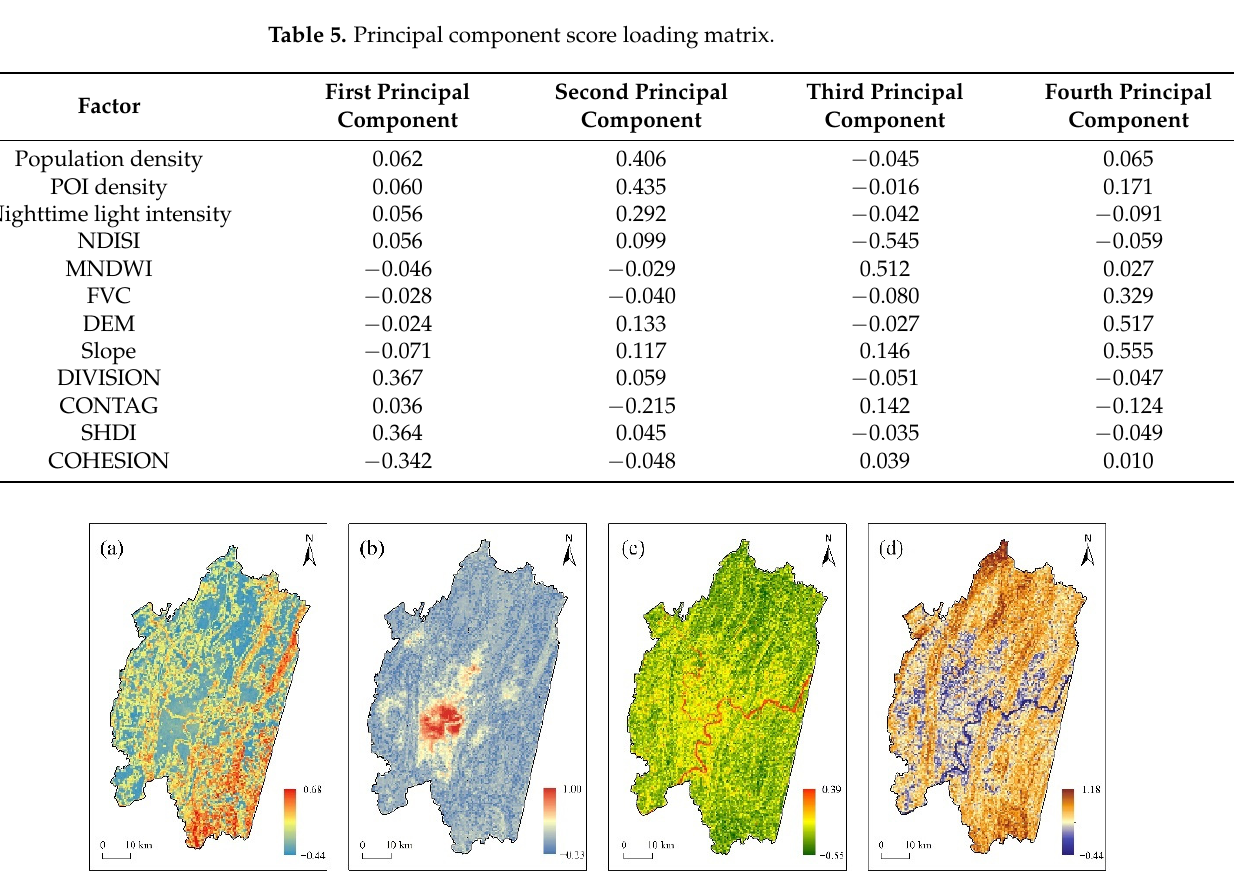
Table 5. Principal component score loading matrix